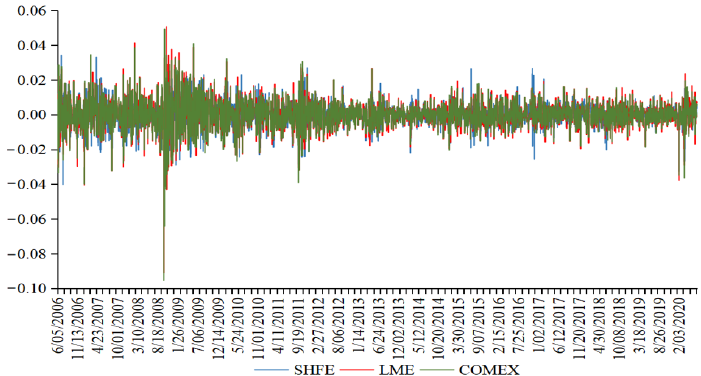
Figure 1. SHFE, COMEX, LME logarithmic return trend chart.